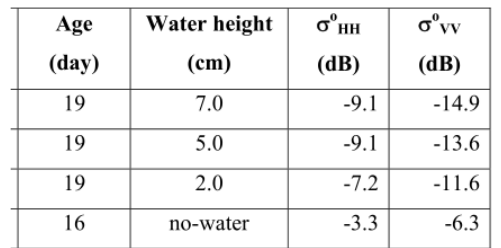
Table-2: Backscattering coefficients after 19 days of transplantation